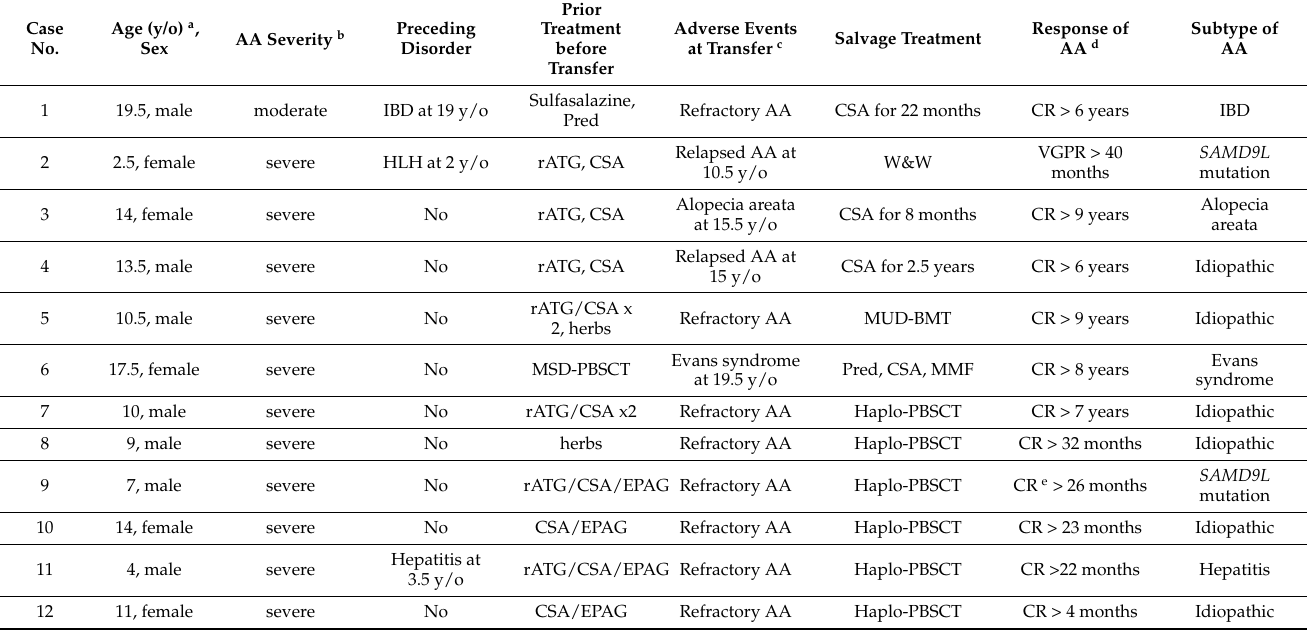
Table 1. Summary of the clinical characteristics of the